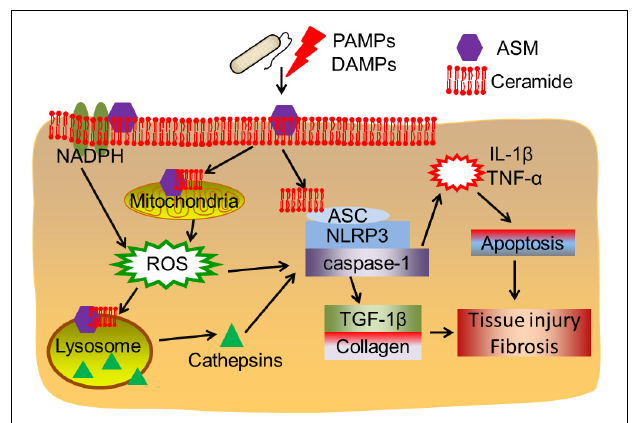
FIGURE 1 | Acid sphingomyelinase/ceramide system in inflammasome signaling and tissue fibrosis. Upon PAMPs or DAMPs exposure, ASM is activated and ceramide enriched domains are formed. Ceramide enriched domains may either directly interact with the ASC-NLRP3-caspase-1 inflammasome complex, or, ASM-ceramide system may induce NADPH oxidase or mitochondrial ROS production or cathepsins released after lysosome rupture, leading to inflammasome activation. The subsequent cytokine production and TGF- β 1 activation may contribute to cell apoptosis, tissue injury and